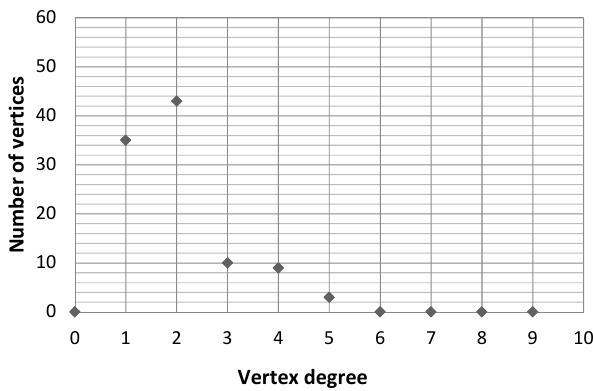
Figure 9. Vertex degree distribution after removing STW and BGC nodes.